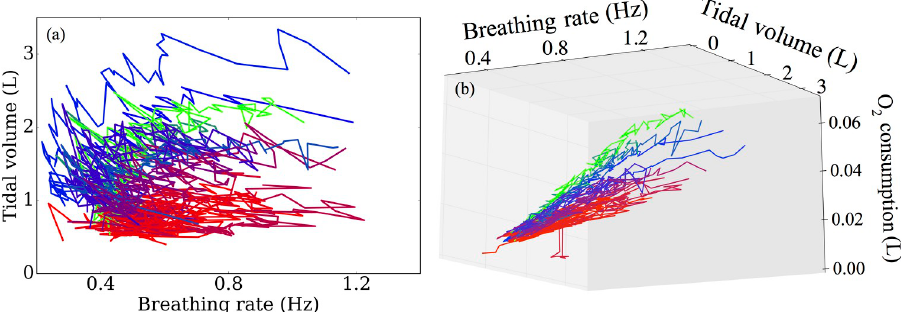
Fig 7. (a) Breathing patterns subdivided into the breathing rate and tidal volume. These data appear uninformative for predicting test performance. (b) With the additional inclusion of the oxygen consumption at a fixed rate of breathing, we find that these variables now almost perfectly capture variation in participant